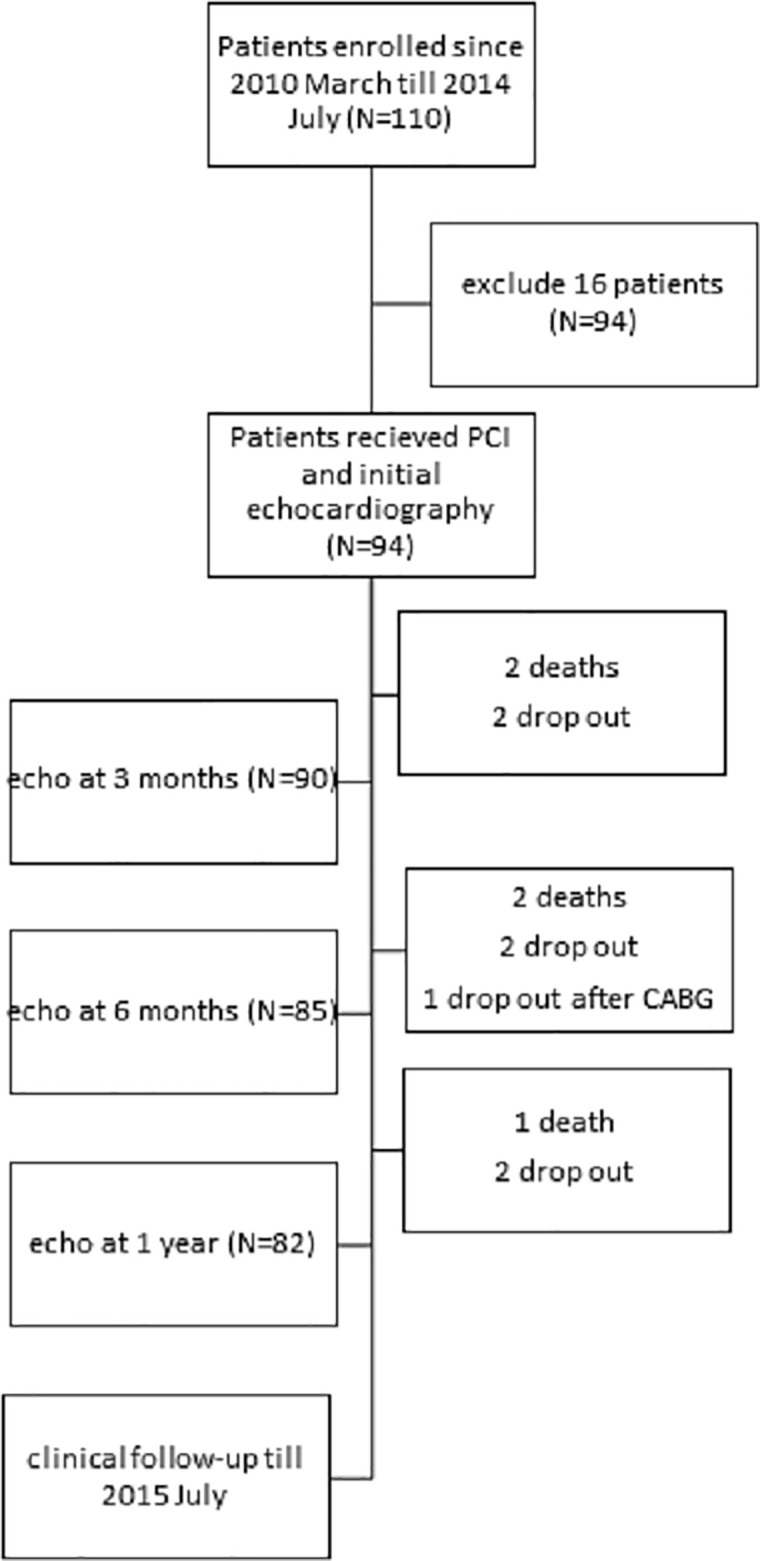
Flow chart of the study protocol.